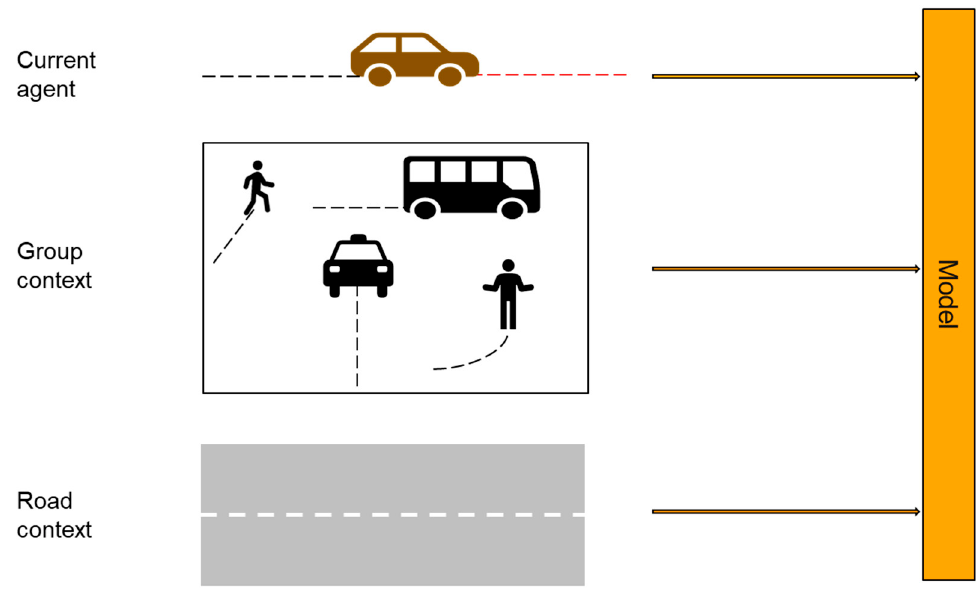
Figure 1. An overview of the multimodal method.